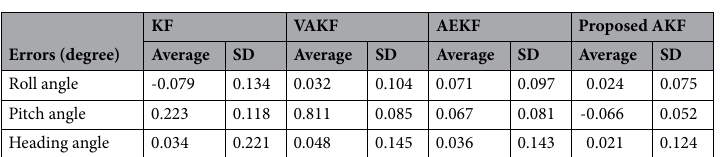
Table 2. Results comparison in the accelerated linear